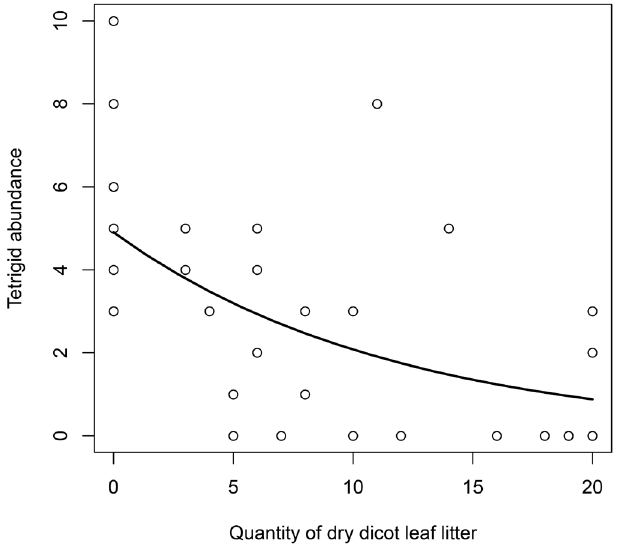
Figure 3. Correlation between total abundance of pygmy grasshop- pers and dry dicot leaf litter. The model was fitted using generalized linear mixed-effects model using Poisson error structure.